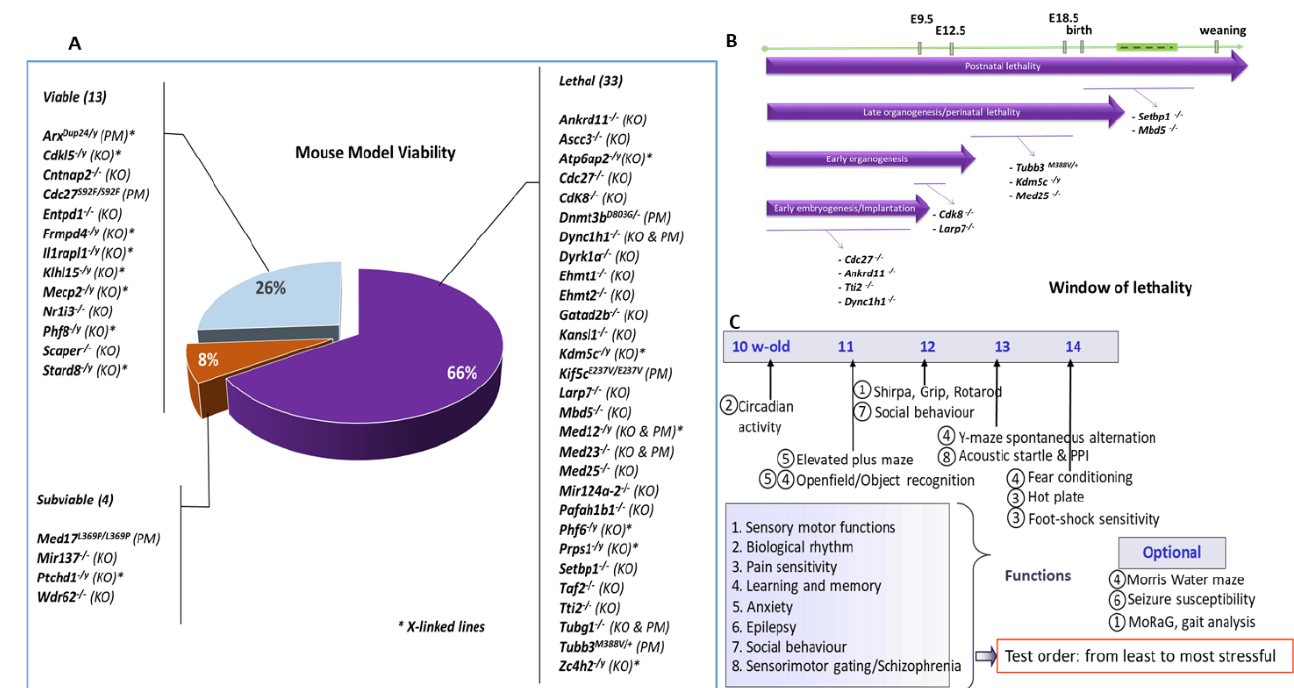
Figure 1. ( A ) Schematic representation of lethality. The percentage of lethal, sub-viable and viable mutant lines is presented with the list of lines for each category. ( B ) Time window of lethality analysed for 11 selected lethal lines. ( C ) Behavioural phenotyping scheme. Several tests were used for assessing a wide range of CNS functions; tests are ordered from least to most stressful.